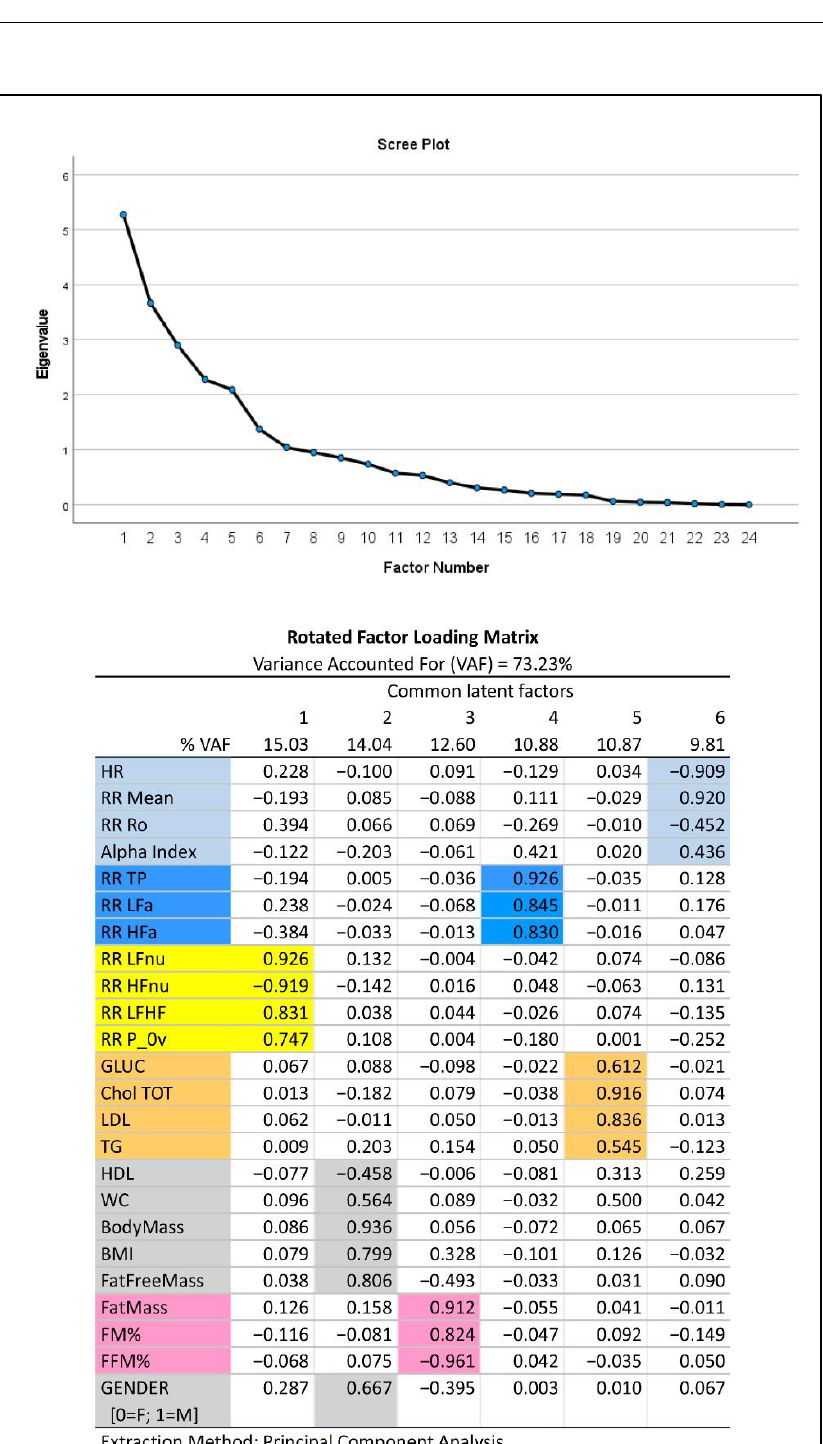
Figure 2. Exploratory Factor Analysis (EFA) of major autonomic and metabolic variables in Olympic athletes. Top panel: Scree plot. Bottom panel: color-coded representation of the rotated factor loadings. Colored cells depict clusters of variables based on their link with the extracted common factors, which represent the primary latent domains to consider. These domains (ordered in decreasing sense according to the individual VAF) are interpreted through the factor loadings as follows: oscillatory (latent domain 1, yellow), body mass and gender (latent domain 2, grey), body composition (latent domain 3, pink), amplitude (latent domain 4, blue), biochemistry (latent domain 5, ocher) and pulse (latent domain 6, light blue).